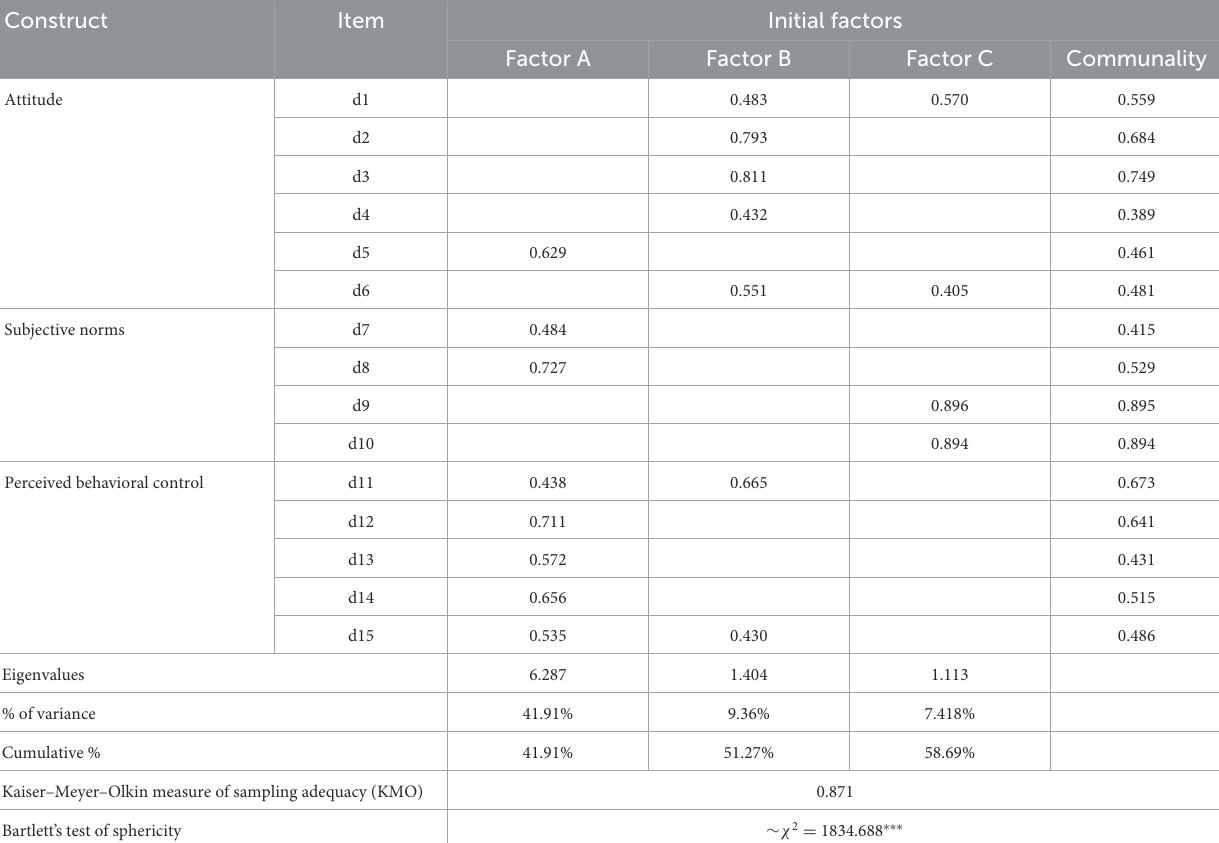
TABLE 3 Factor loading for the contributing items in questionnaire ( N = 249).